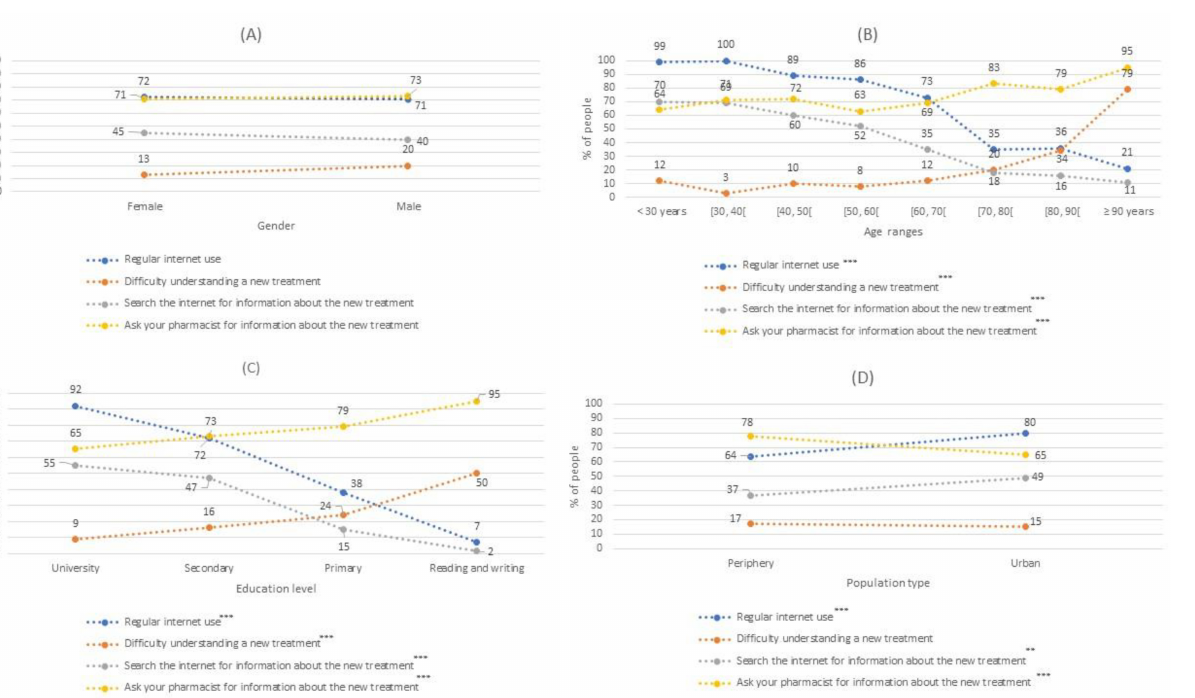
Figure 4. The percentage of people who habitually use the internet to search for health information, had difficulty understanding new treatments prescribed by their doctor, sought information about new treatments prescribed by their doctor, or asked their pharmacist for information about the new treatment Modalities used to request an appointment al the health center by gender ( A ); by age ( B ), by educational level ( C ) and by population type ( D ). **: p -value < 0.01; ***: p -value <